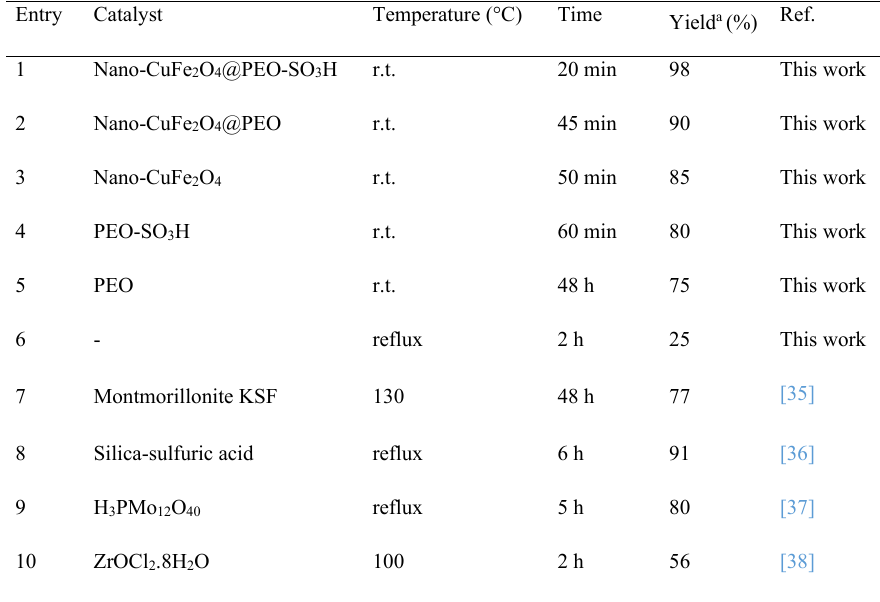
Table 3. A comparison of the effects of some catalysts with that of the present nanocatalyst on the model reaction.